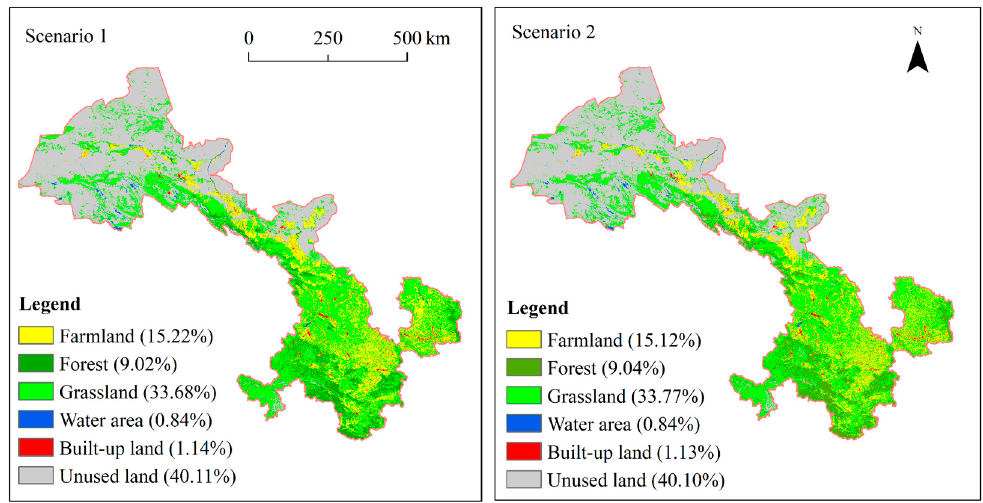
Figure 6. Prediction for land use and cover in 2030 under two scenarios.